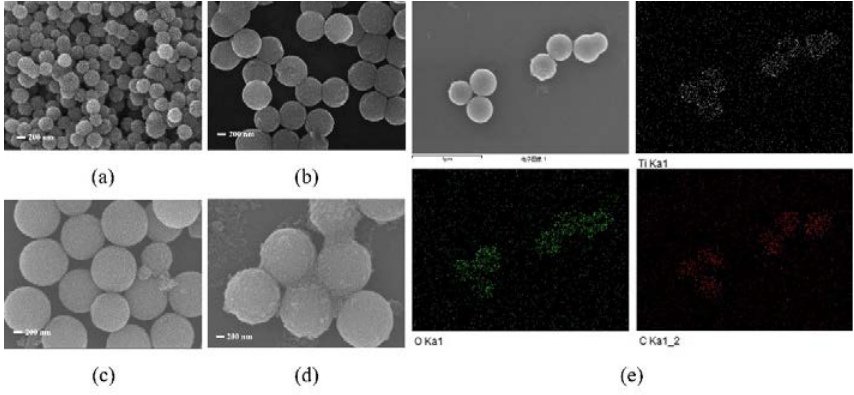
Figure 3. ( a ) PP@TiO 2 -25, ( b ) PP@TiO 2 -50, ( c ) PP@TiO 2 -75, and ( d ) PP@TiO 2 -100 SEM images; ( e ) the mapping pattern of PP@TiO 2 -50.